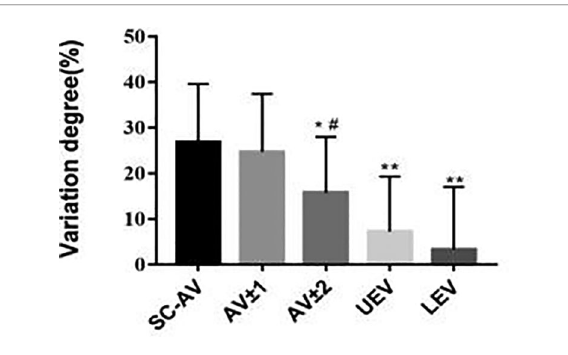
FIGURE 5 In AIS patients, asymmetrical changes in vertebral-body bone quality were most signi fi cant in the apical region. Comparison of variation degree of bone quality in different regions of the structural curve in AIS patients. Total 30 patients with Lenke type 1A AIS and 30 paired controls were included in this study. * P <0.05 vs.